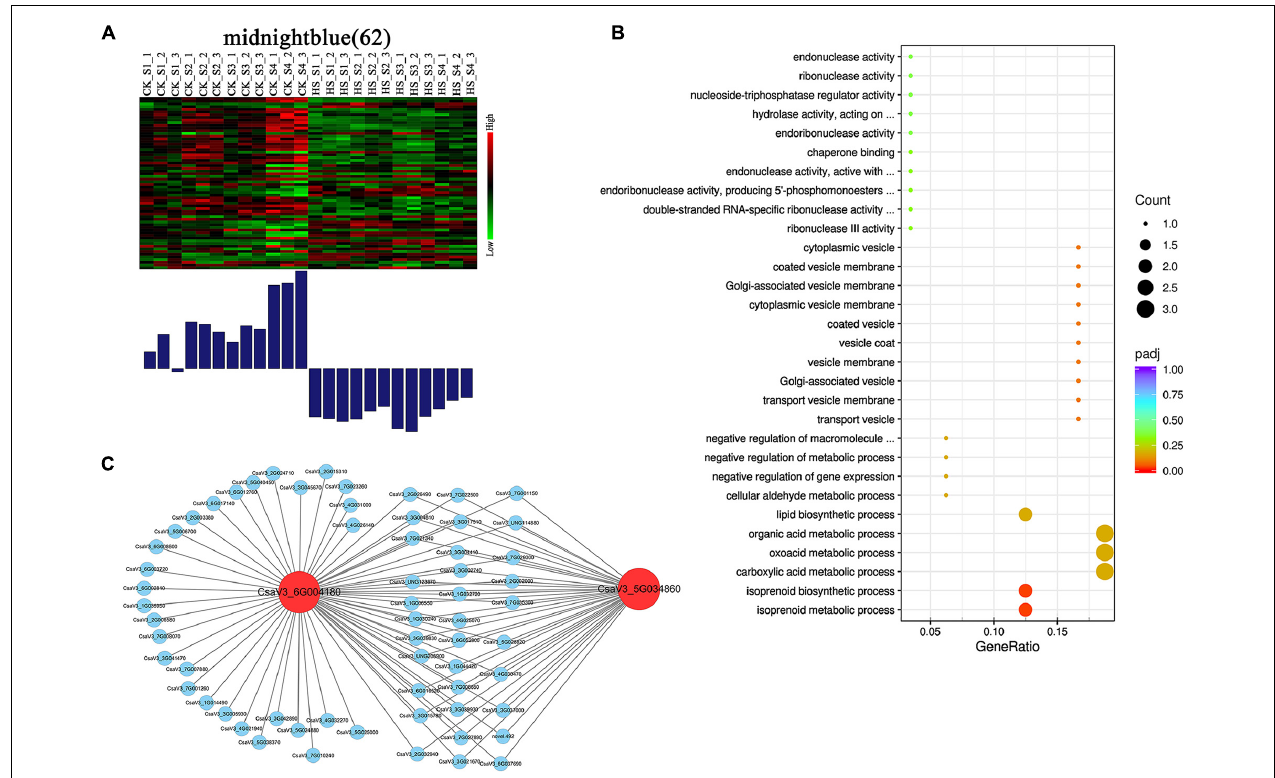
FIGURE 7 | Expression profile and transcriptional regulatory network of midnightblue module associated with opposite expression patterns in CK and HS. (A) The midnightblue modules showing opposite expression patterns in CK and HS. Heatmaps show the expression profile of all the co-expressed genes (number given on the top) in the midnightblue modules. The color scale represents Z-score. Bar graphs (below the heatmaps) show the consensus expression pattern of the co-expressed genes in midnightblue modules. The bars show opposite expression patterns in CK and HS. (B) The GO terms (biological process) of genes in midnightblue modules. (C) High co-expressed genes of two hub genes in midnightblue